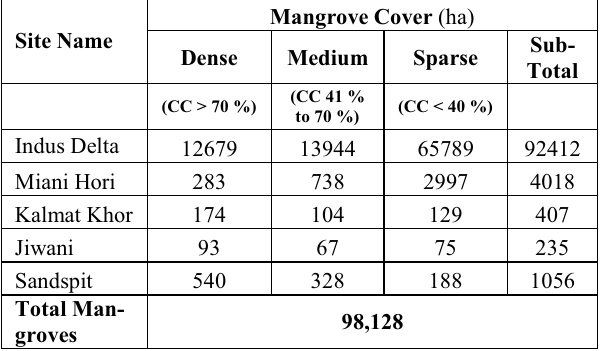
Table 2: Mangroves Cove Statistics of